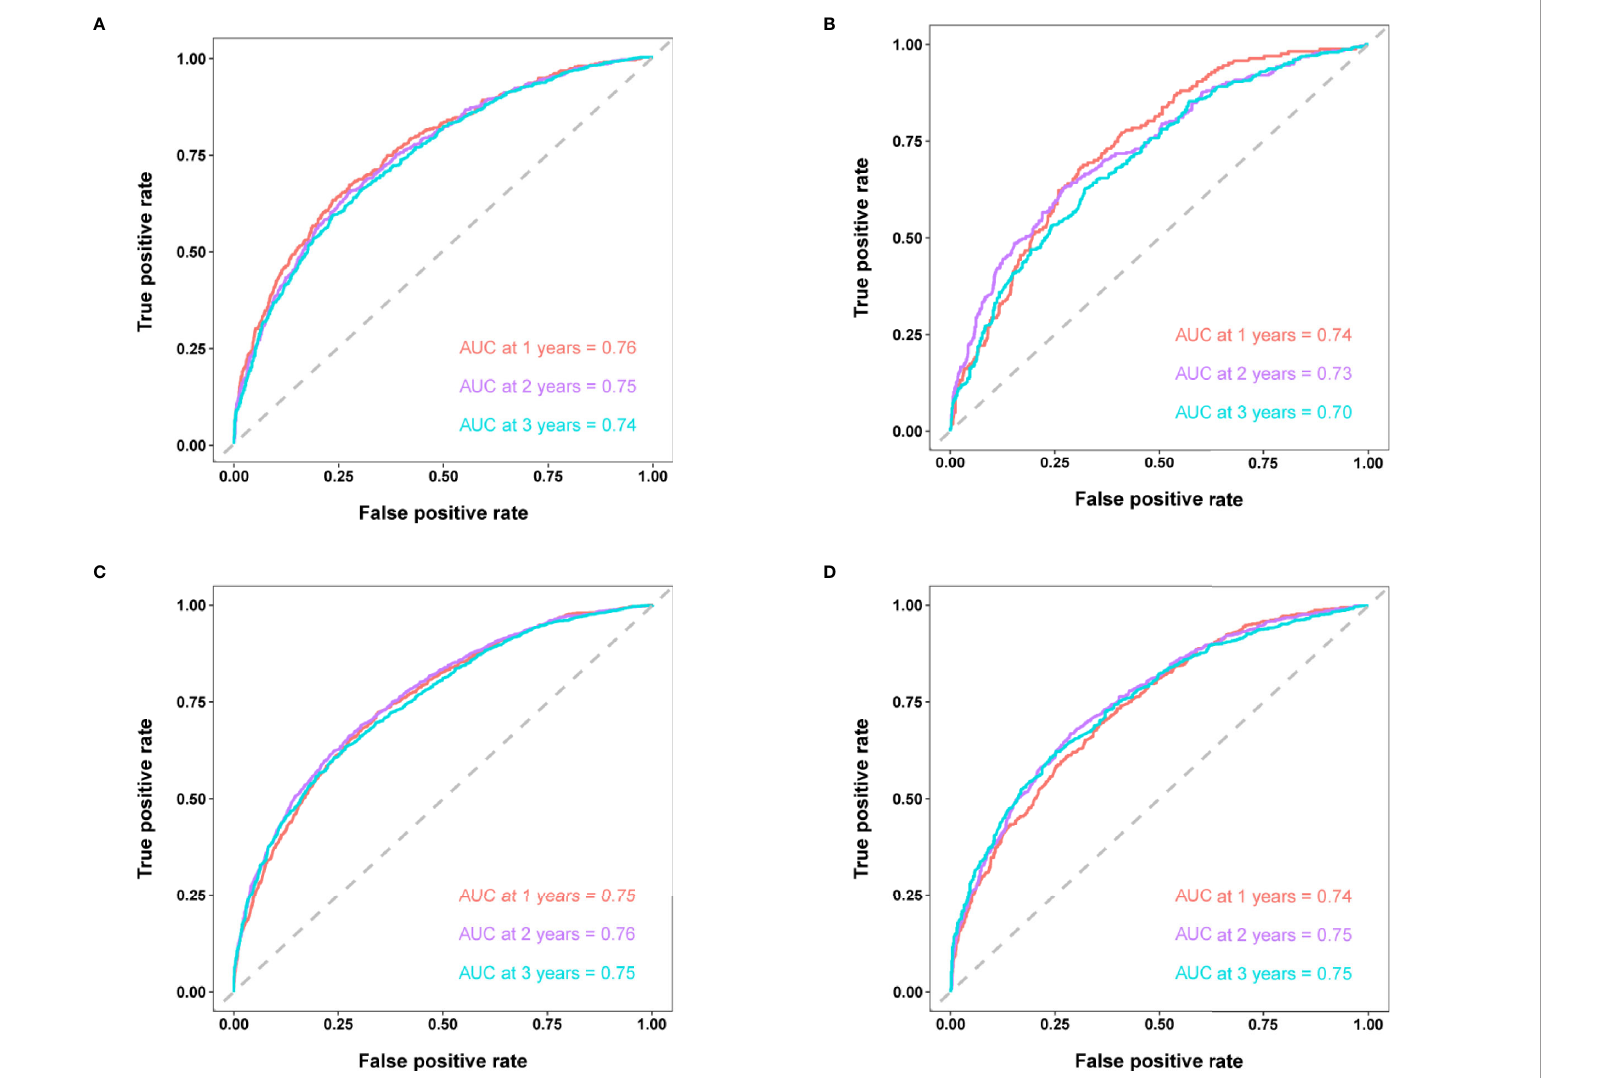
FIGURE 6 | (A) Time-dependent ROC curves of BCSD at 1-,2- and 3-year intervals in the training set in bone-only metastatic pattern. (B) Time-dependent ROC curves of BCSD at 1-,2- and 3-year intervals in the validation set in bone-only metastatic pattern. (C) Time-dependent ROC curves of BCSD at 1-,2- and 3-year intervals in the training set in viscera metastatic pattern. (D) Time-dependent ROC curves of BCSD at 1-,2- and 3-year intervals in the validation set in viscera metastatic